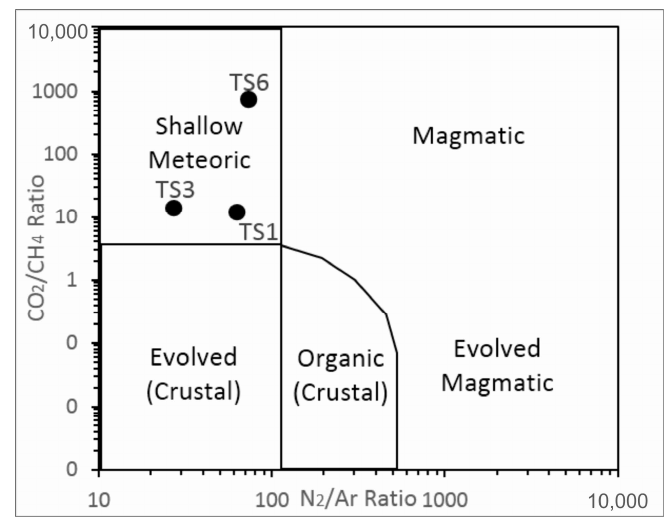
Figure 12. The ratio diagrams of CO 2 /CH 4 versus N 2 /Ar show the origin of the fluid system from meteoric water.